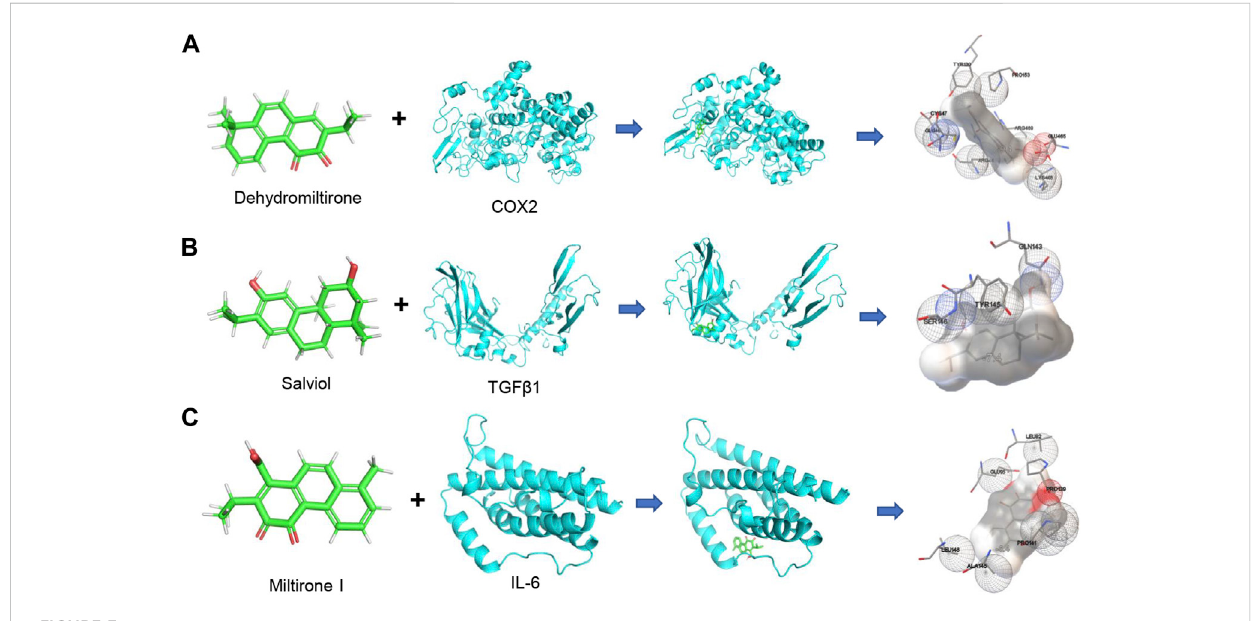
FIGURE 3 Diagram of molecular docking models between potential targets and core components. (A) Dehydromiltirone – COX2. (B) Salviol – TGF- β 1. (C) Miltirone I – IL-6. The hydrogen atoms in the receptor are in close contact with atoms in the ligand that are shown as